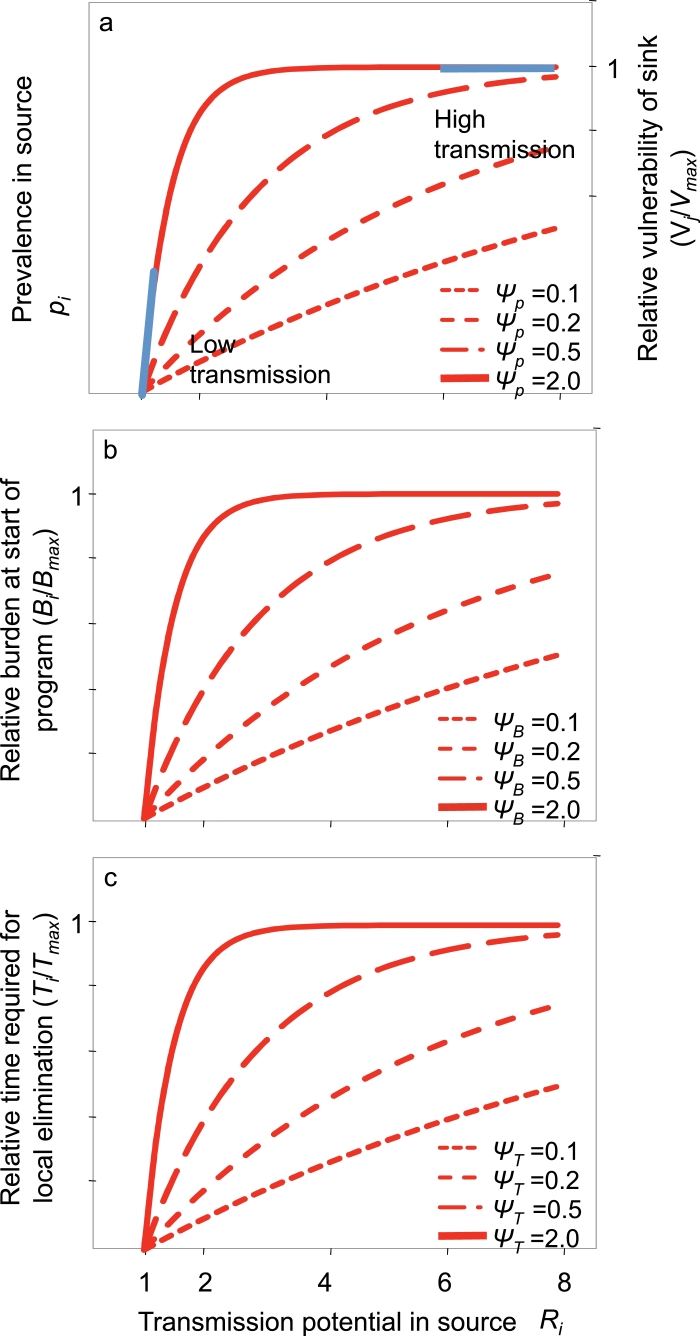
Proposed relationships of equilibrium prevalence, vulnerability, disease burden and duration of intensified measures needed to achieve elimination with transmission potential. a) Prevalence and vulnerability: vulnerability is proportional to prevalence in the complementary population so they are represented with the same curves. The blue lines correspond to the extreme cases analysed in detail. b) Disease burden. c) Duration of elimination program. (For interpretation of the references to color in this figure legend, the reader is referred to the web version of this article.)